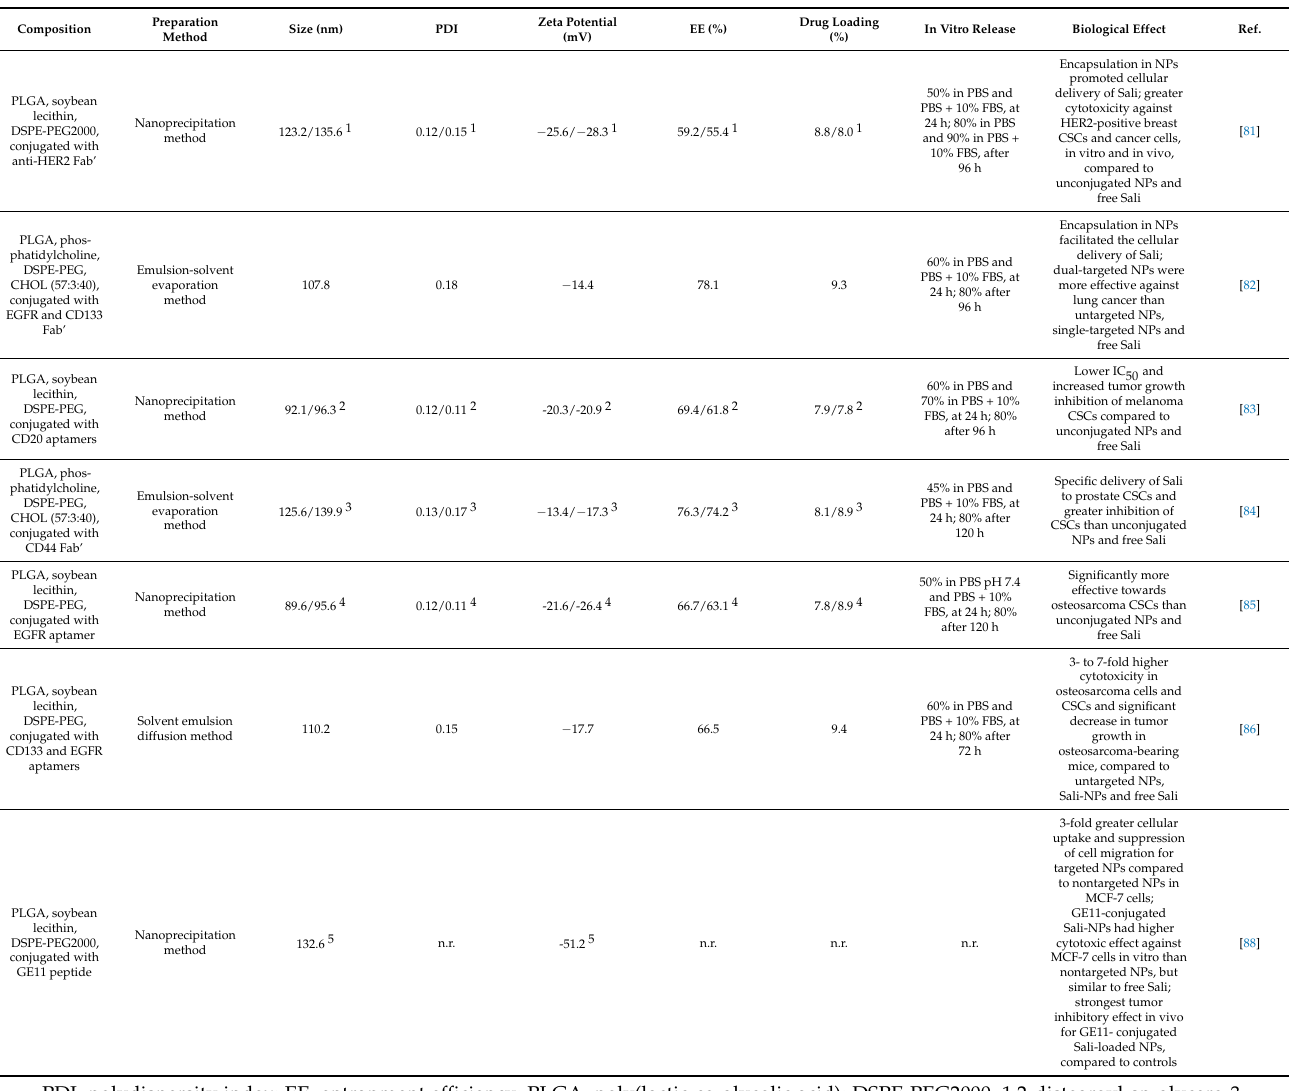
Table 5. Polymer–lipid hybrid nanoparticle formulations with